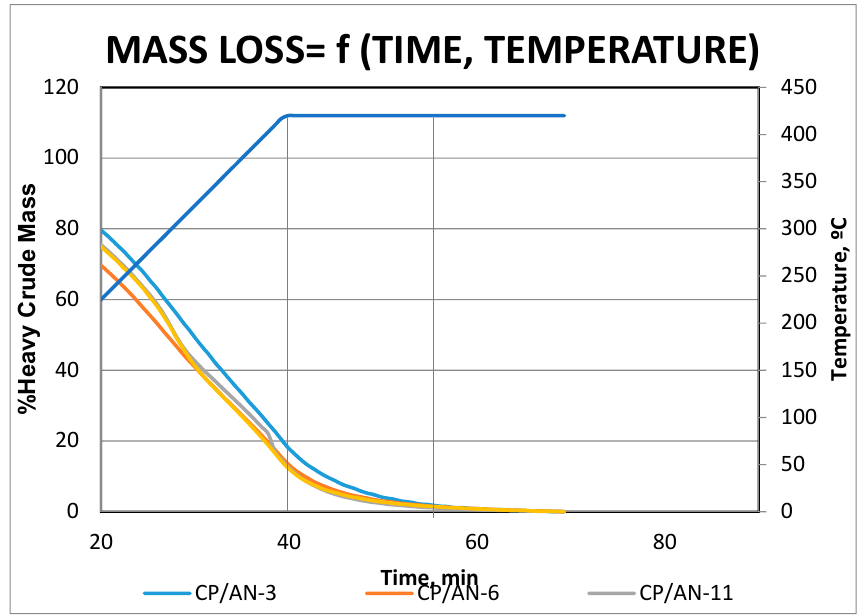
Figure 5. Thermogravimetric curves at 420 °C.